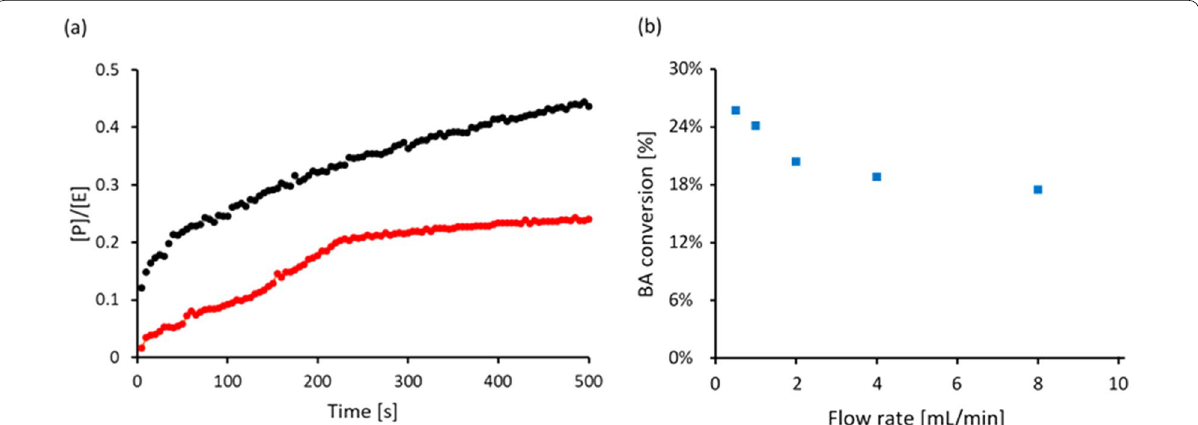
Fig. 3 a Formation of the BA hydrolysis product in batch conditions (per unit concentration of Trypsin enzyme in the system) using 3D printed hollow cylinders with 7.31 mg/g immobilized trypsin (red) and using free trypsin in solution at a concentration of 2 mg/mL (black). b BA conversion obtained from continuous operation of immobilized enzyme bioreactor with Schoen gyroid bed geometry in steady‑state mode at different flow rates. In both cases, the monoliths were equilibrated in 50 mM Tris buffer pH 8, followed by introduction of a 1 mM BAEE substrate solution (in 50 mM Tris buffer pH 8), with UV monitoring of the formation of the hydrolysis product (BA) at 253